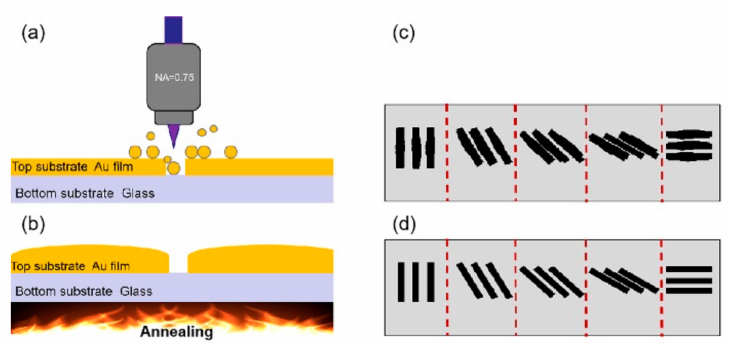
Figure 1. Schematic manufacturing flow of the geometric phase element on gold film by femtosecond–laser direct writing ( a ) and annealing ( b ); ( c , d ) schematic nanostructure before and after